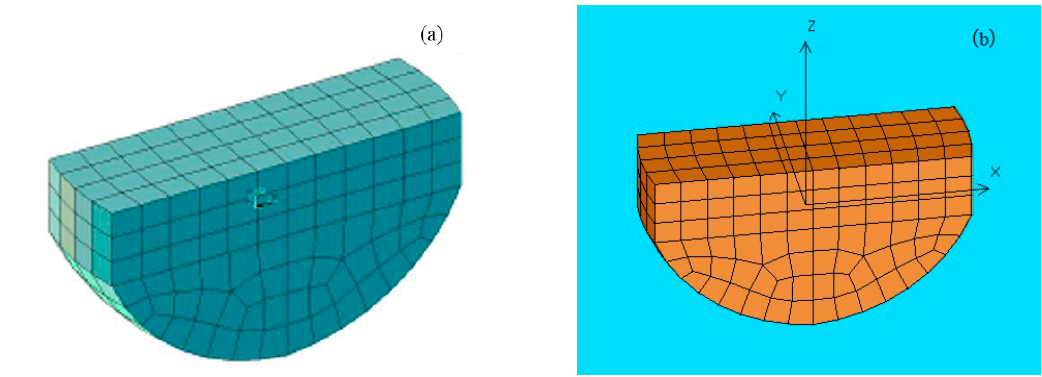
Figure 3. The floating frequency domain calculation model. (Sub-figures: ( a ) APDL grid model; ( b )